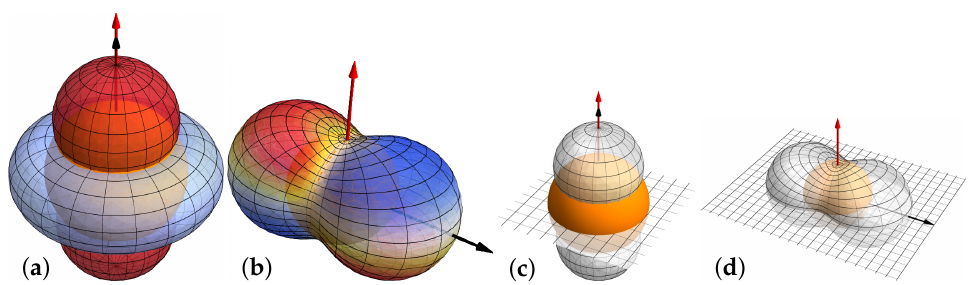
Figure A3. Schematic drawings of the electrospheres. ( a ) Electrosphere for aligned rotators, resem- bling the rotating Terrela configuration familiar to plasma physicists. ( b ) Electrosphere for orthogonal rotators. The meshed semi-transparent surfaces are the sharp boundaries of the charged regions. The plasmas with charges indicated by the color (red for negative, blue for positive) fill the space between these surfaces and the stellar surface (the orange surface faintly visible behind the meshed surface). There are no currents flowing in any region of the electrospheres. ( c , d ) The trap surfaces in vacuum magnetospheres as given by Equation (A18). The orange sphere signifies the neutron star, the red arrow is the rotation axis and the black arrow the magnetic